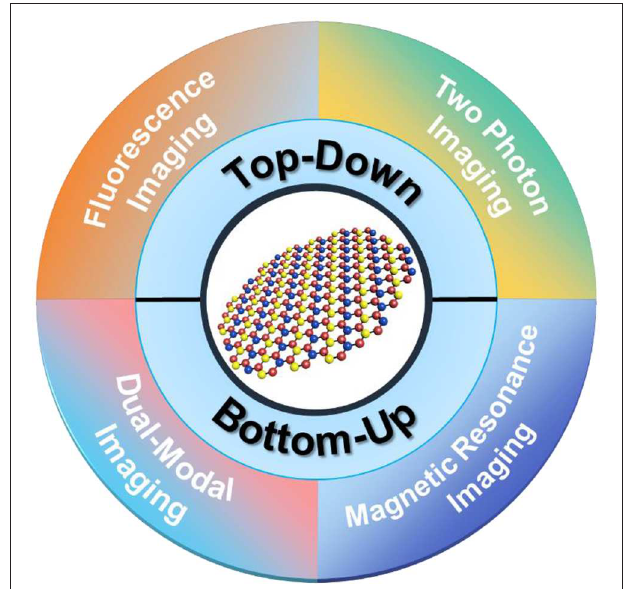
FIGURE 1 | Graphene quantum dots (GQDs) for bioimaging applications. The synthesis strategies of GQDs, including top–down and bottom–up are summarized, followed by a comparative and balanced discussion on their bioimaging (fluorescence imaging, two-photon imaging, magnetic resonance imaging, and dual-modal imaging)